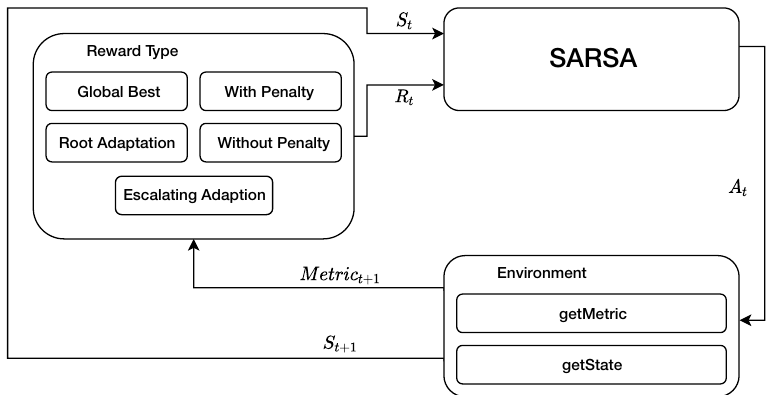
Figure 5. A SARSA scheme for different rewards.